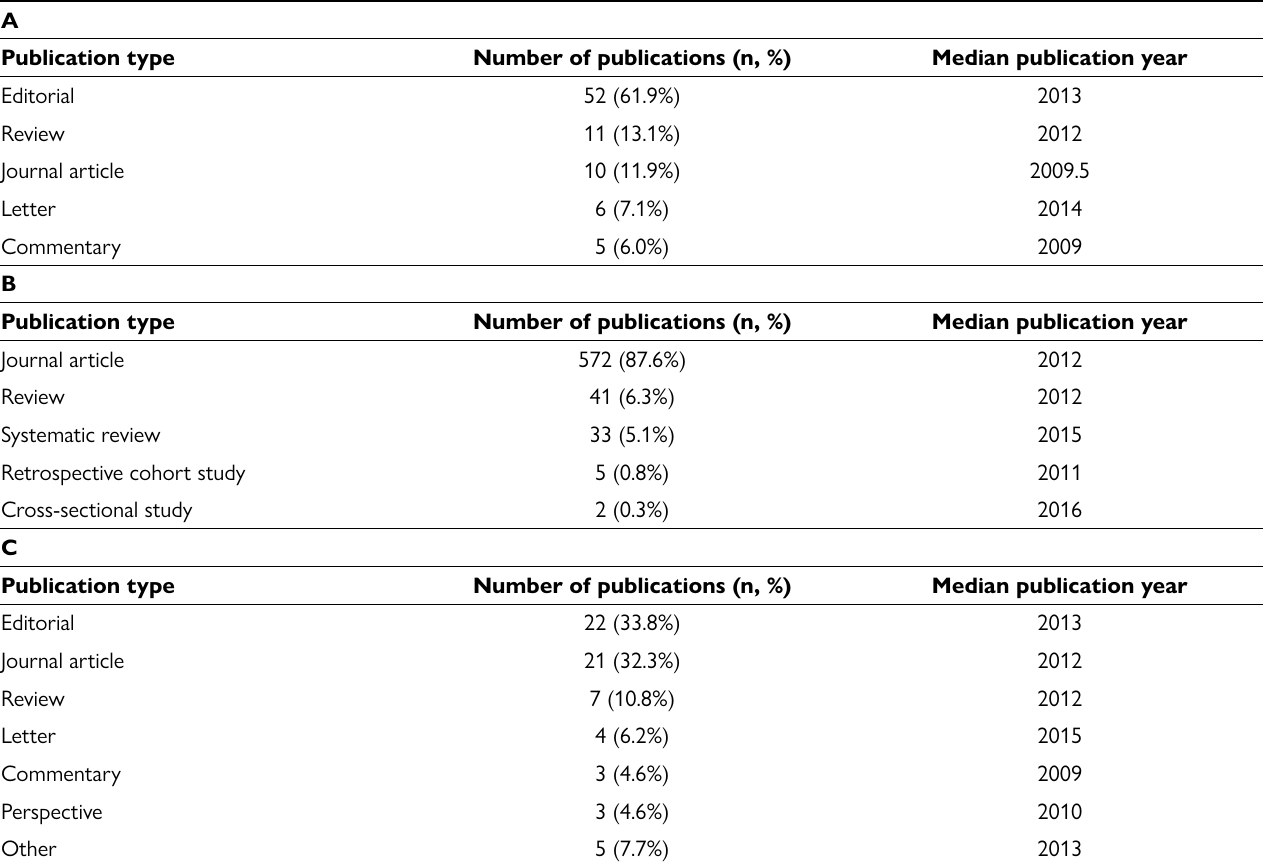
Table 2. Sample characteristics. (A) Displays the sample used for the study’s first objective (n = 84). (B) Shows the sample used for the study’s second objective (n = 653). (C) Presents the sample used for the study’s third objective (n =